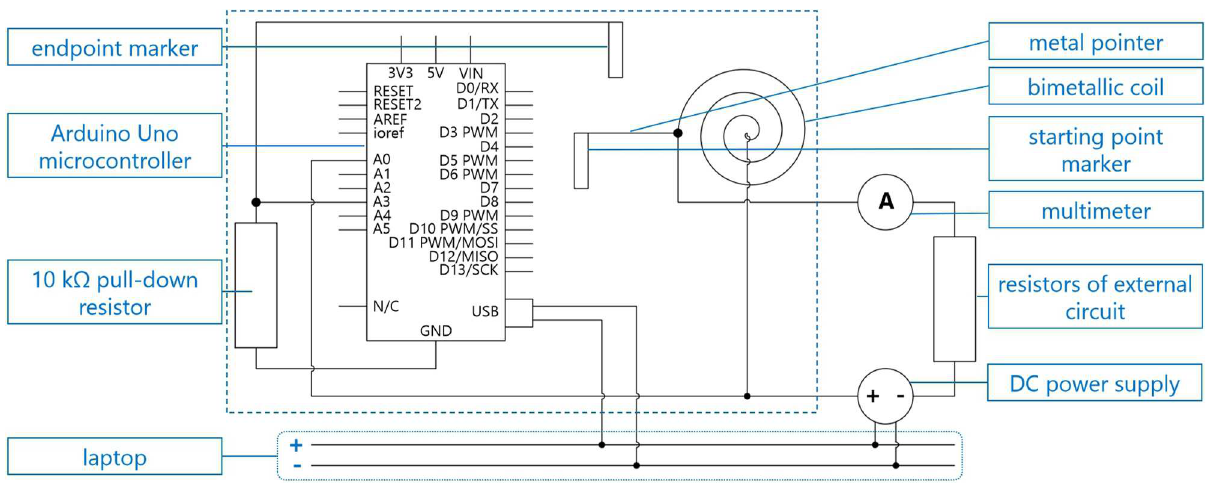
Fig. 1. A schematic diagram of the experimental setup. The part enclosed by the dashed box is the bimetallic ammeter. The conventional current flow is adopted for this diagram. The wires at the bottom show how the microcontroller and the external circuit are powered by the laptop.